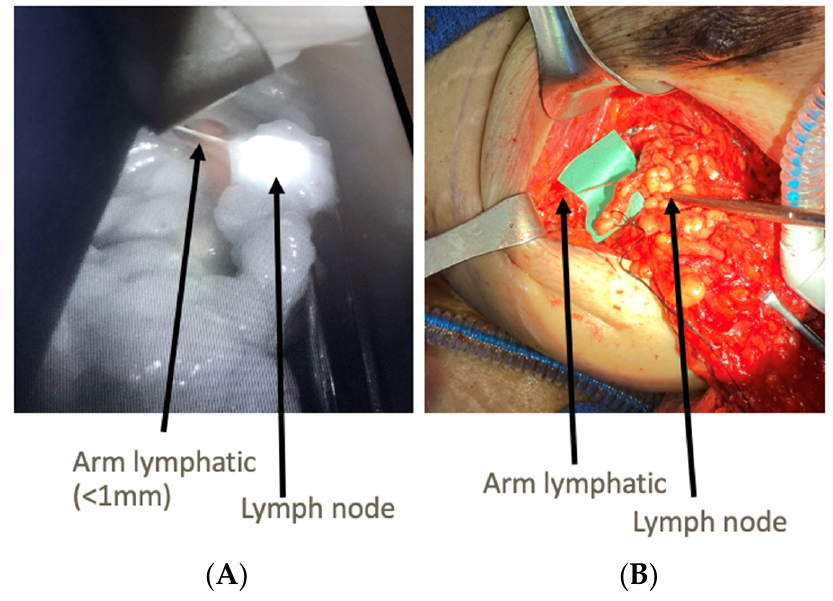
Figure 2. Identification of Structures during ALND: Right axillary lymph node dissection with pectoralis major retracted superiorly. ( A ) demonstrates a well-defined arm lymphatic draining into lymph node using SPY. ( B ) shows the “on the table” correlate during dissection.